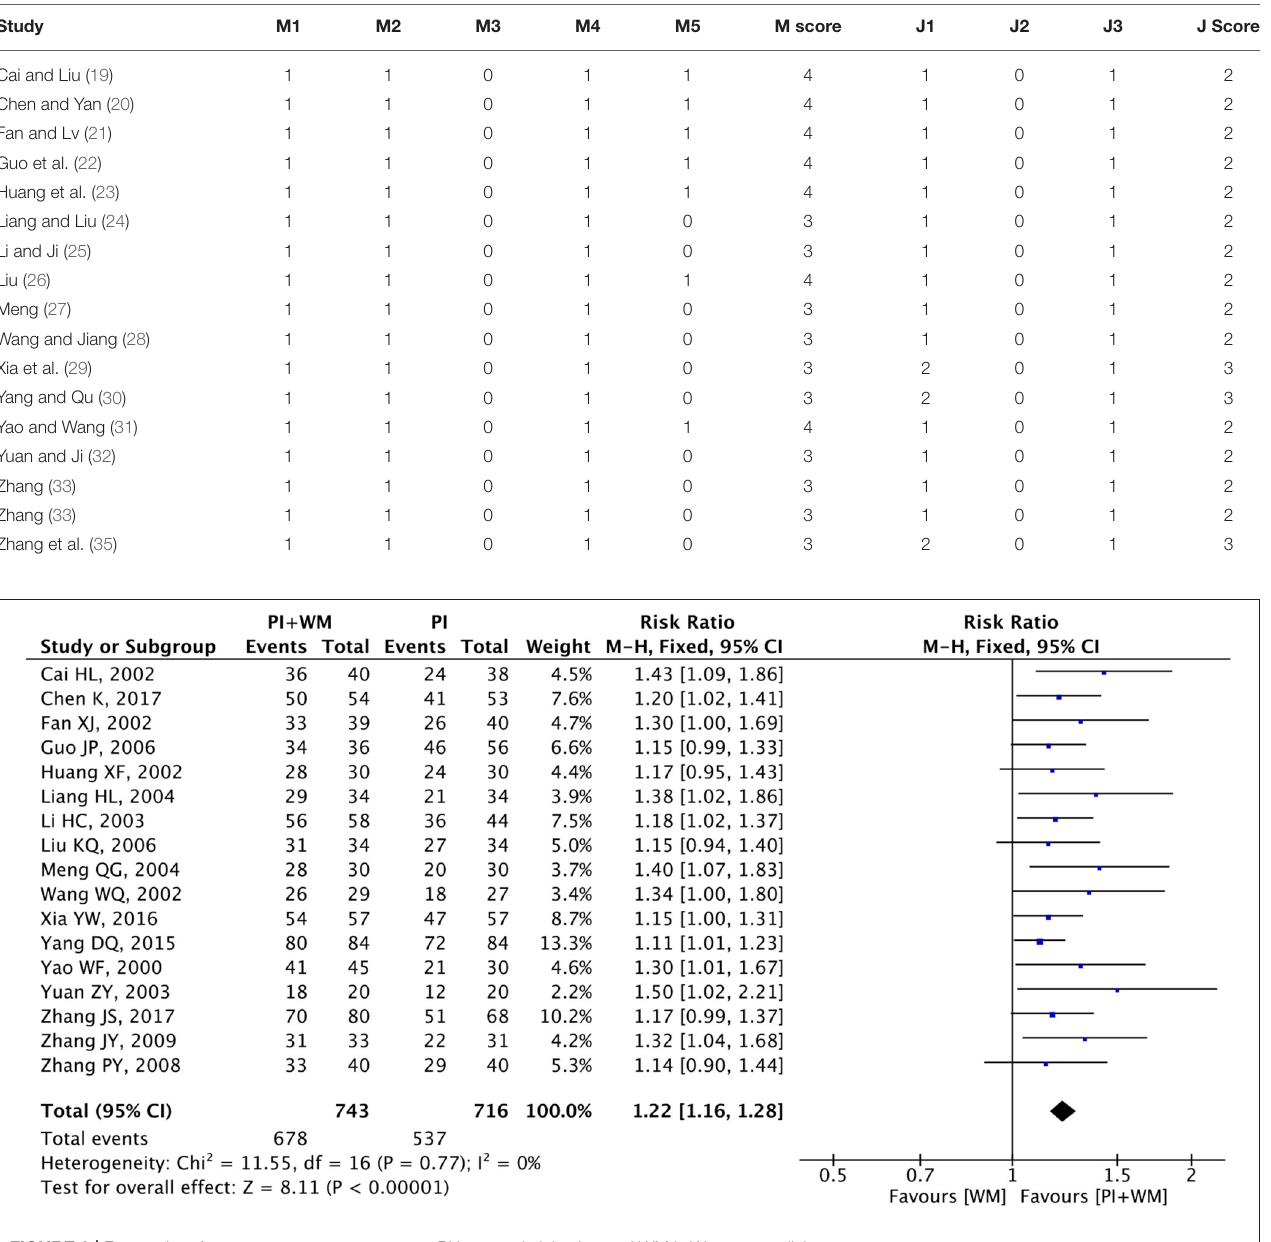
TABLE 2 | Quality of the included RCTs.